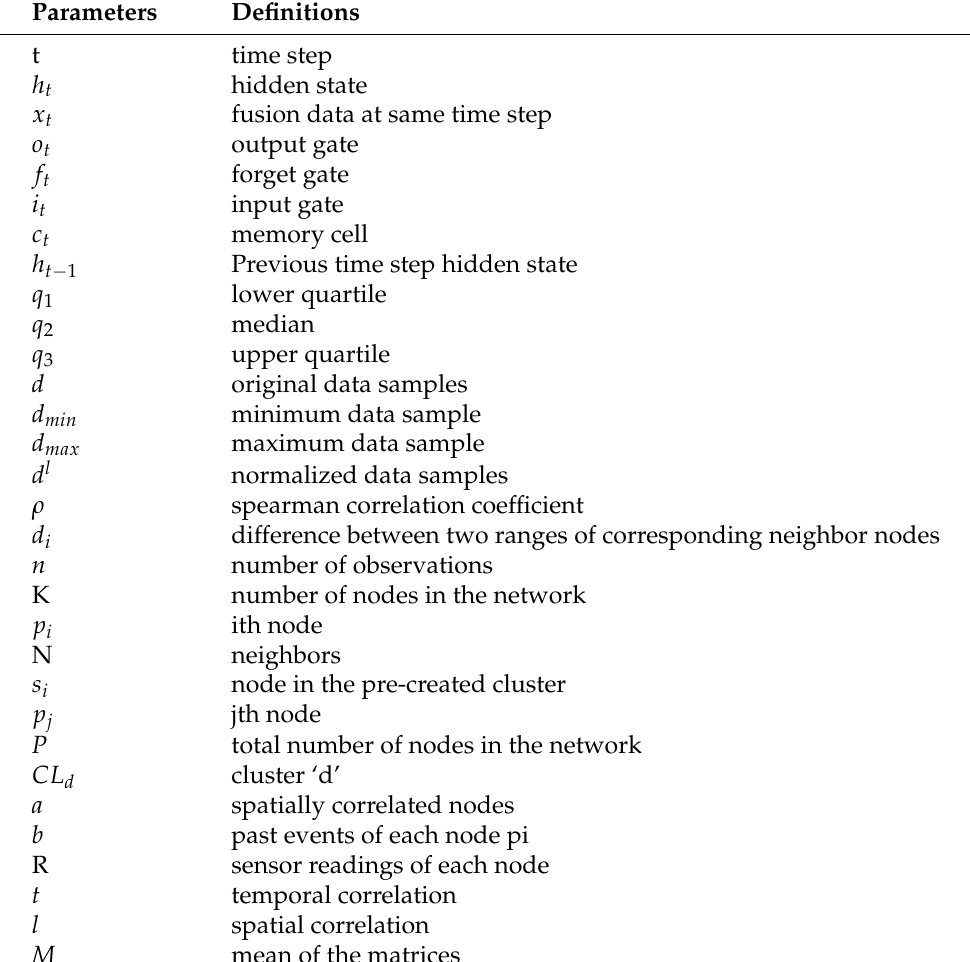
Table 1. Parameters and